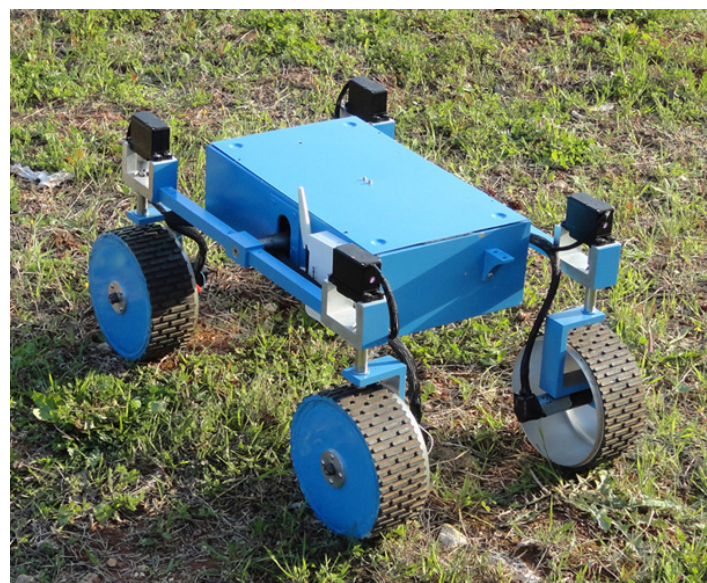
Figure 1. The rover test platform employed in this